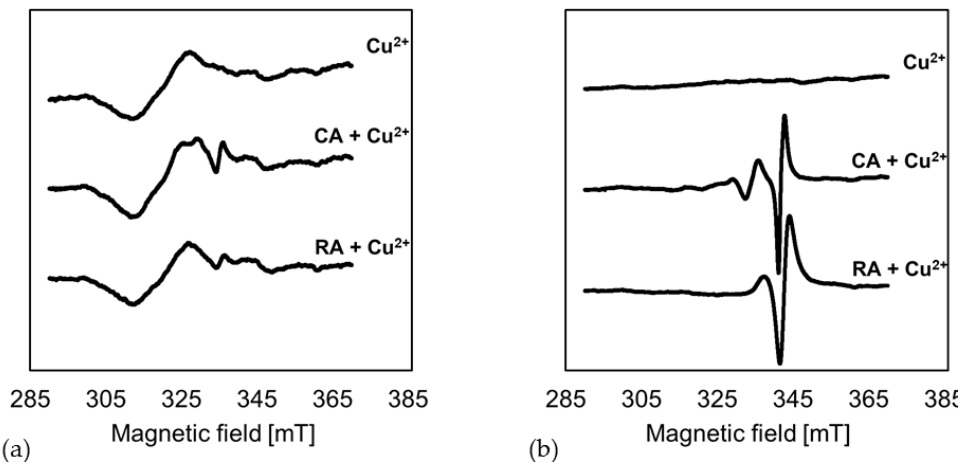
Figure 4. The EPR spectra show the change in the Cu(II) signal in the presence of the β -Lg interfacial film of an emulsion without PCD addition (top) and with the addition of CA (middle) and RA (bottom) at ( a ) pH 6 and ( b ) pH 9. The spectra shown are an individual exemplary series of measurements.